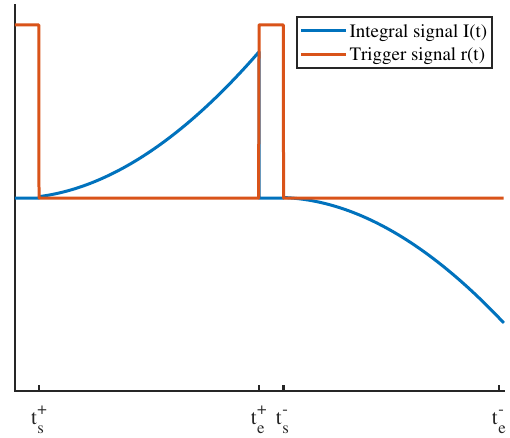
Figure 7. Integral obtained by the IDIM circuit (blue), trigger signal r ( t ) (red) as well as time instants, exemplary shown for α = 0.5.